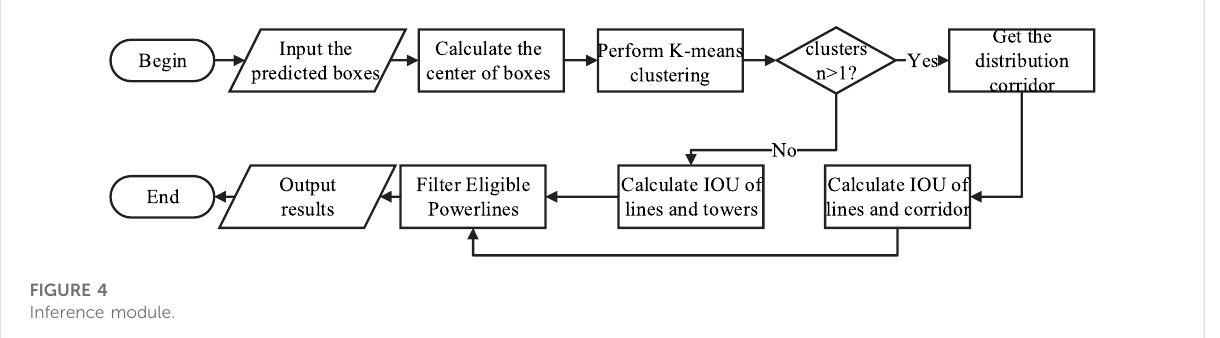
FIGURE 4 Inference module.